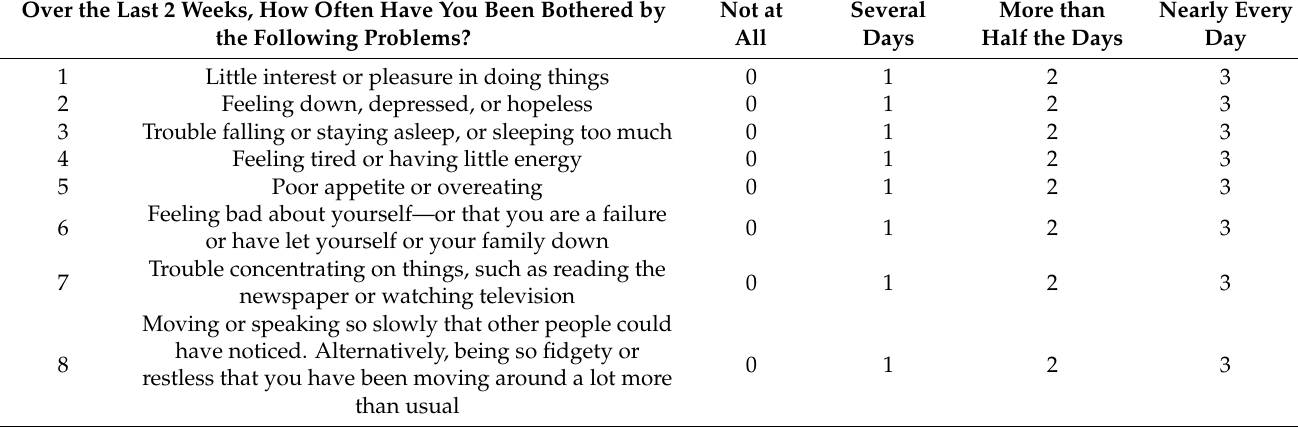
Table 1. Eight questions of the PHQ-8.